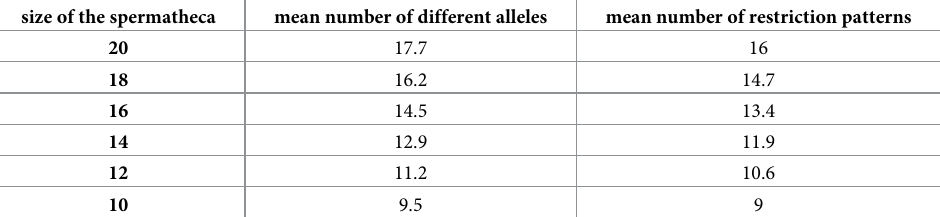
The numbers are mean values obtained after drawing with replacement (n = 10) a specified by the spermatheca size number of records from 80-record subsets (n = 10) of a dataset containing 151 different csd -PSD sequences available in the public